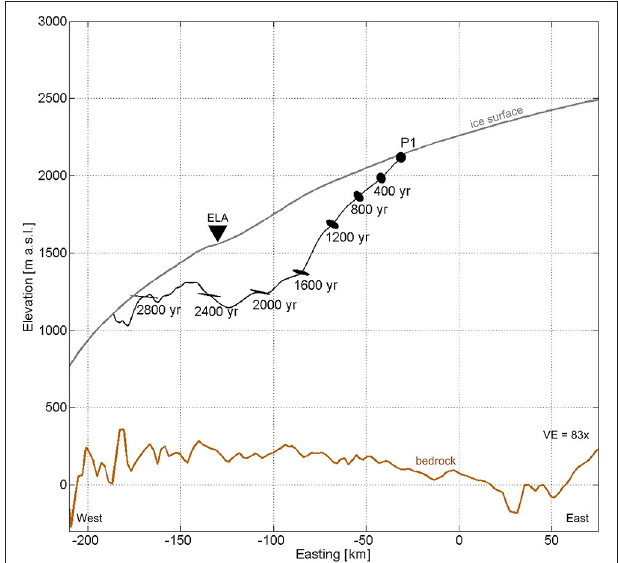
FIGURE 3 | Ice deformation results. The deforming strain ellipsoids are shown along particle path P1 (black line) at 400 year snapshots. The ice surface (gray line), bed (brown line), and the ELA (black triangle) are also shown.